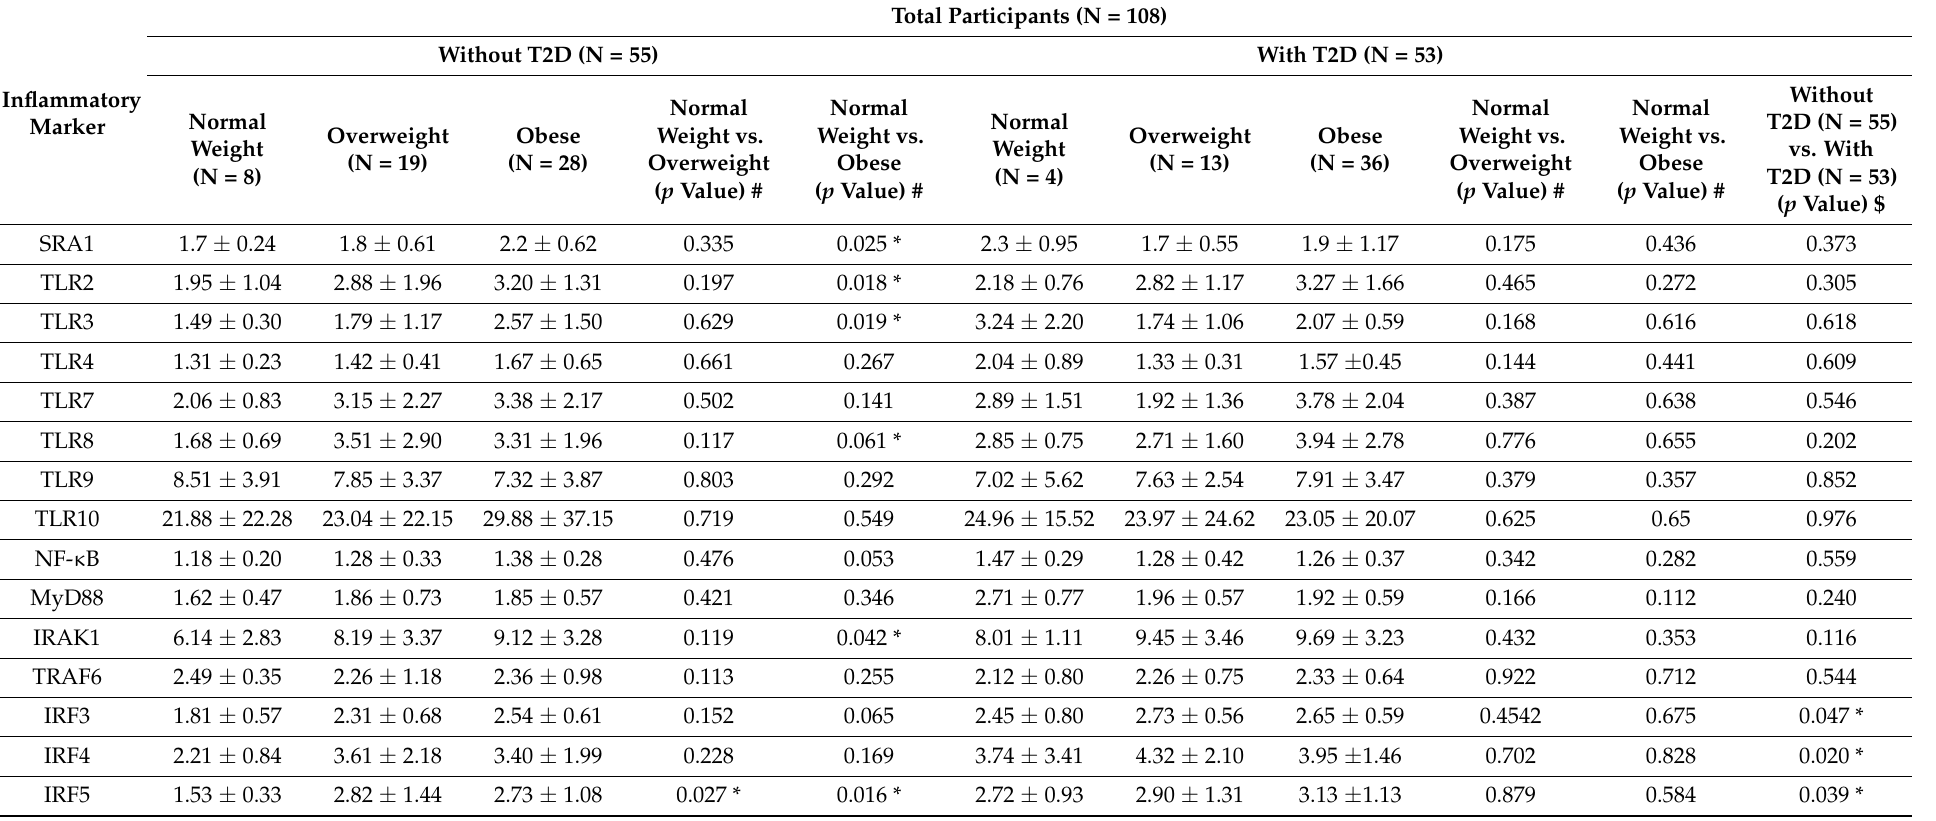
Table 1. Adipose expression (mRNA) of TLRs, their downstream signaling mediators, IRFs, and SRA1 in participants with and without